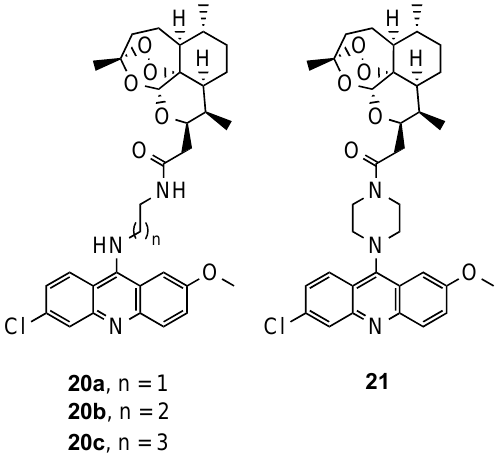
Figure 14. Compounds ( 20 and 21 ) developed by Jones and co-workers [33].